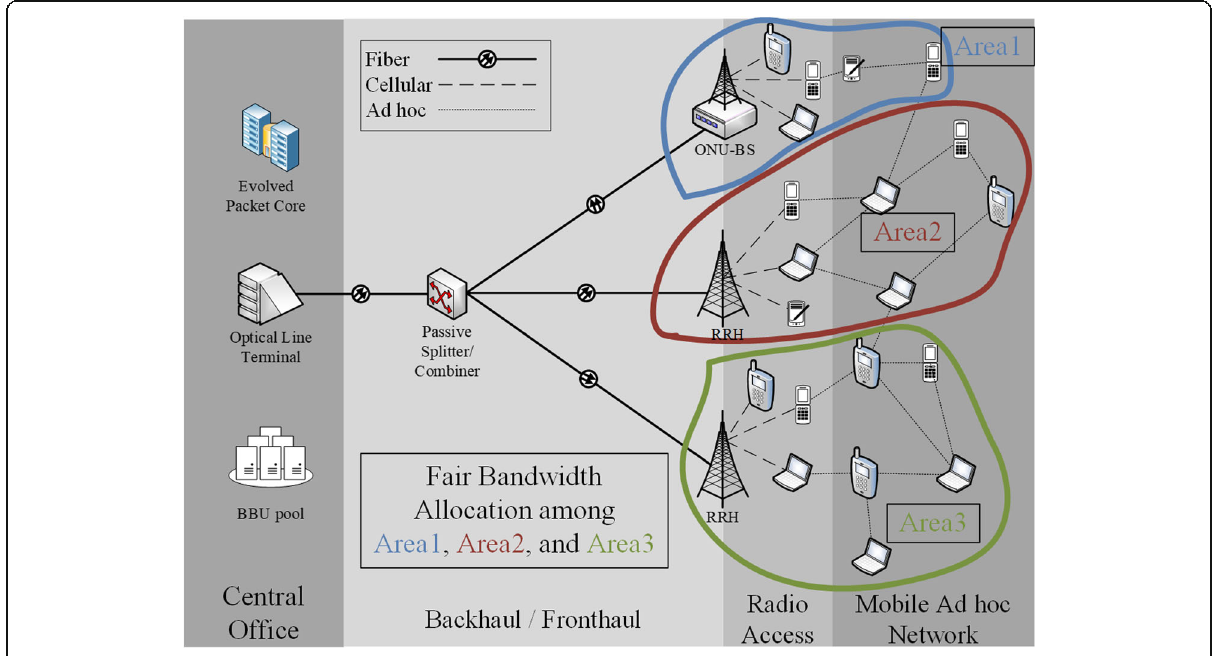
Fig. 5 Fair bandwidth allocation scenario among various MANET